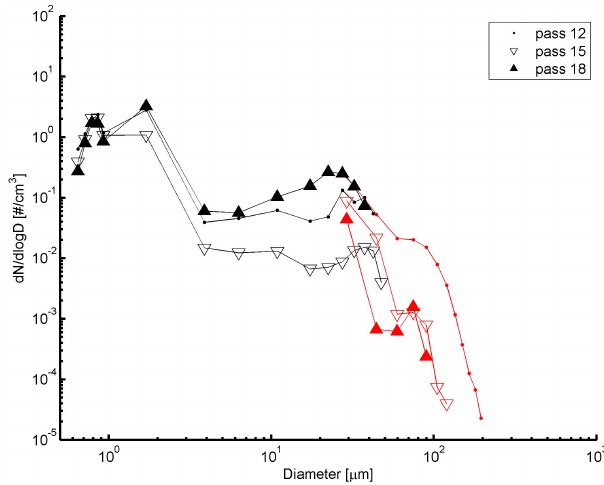
Fig. 13. Average CAS (black) and CIP-GS (red) particle size dis- tributions for sampling of “other” aircraft contrails. Legend denotes passes, see main text for